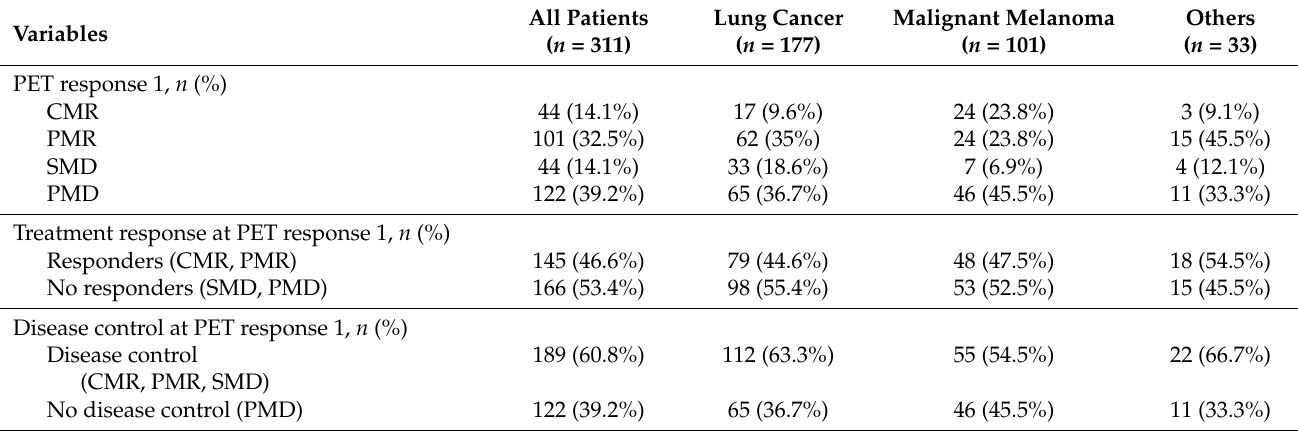
Table 2. PET and clinical